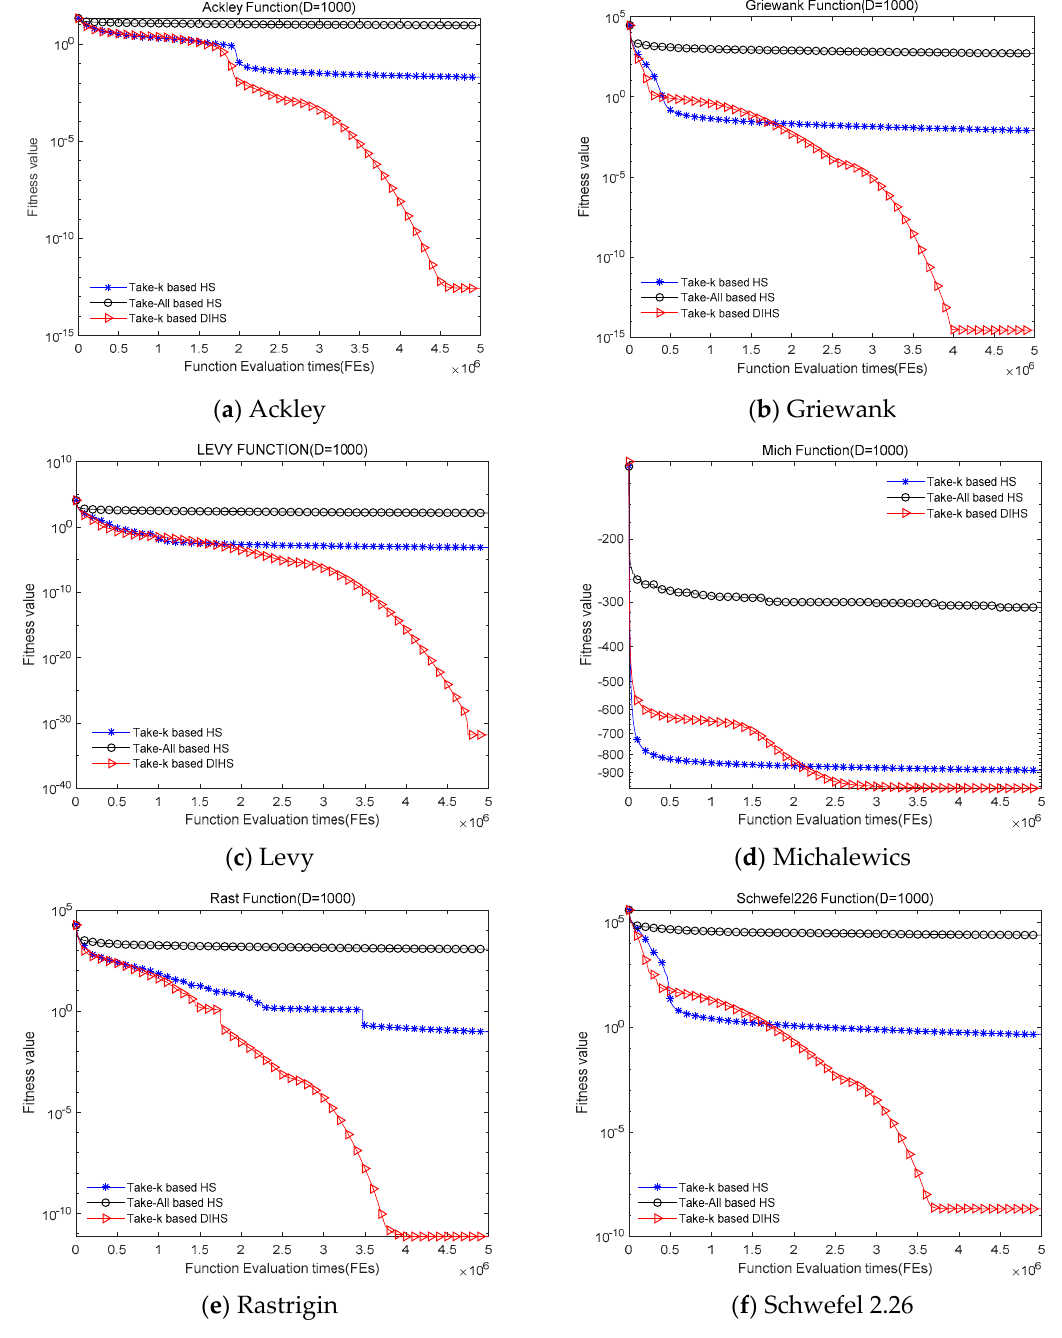
Figure 5. Convergence curves of the take-all and take-k strategies.